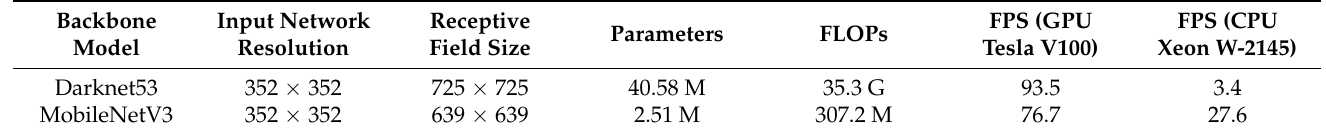
Table 1. Comparison of parameters and performance of different backbone